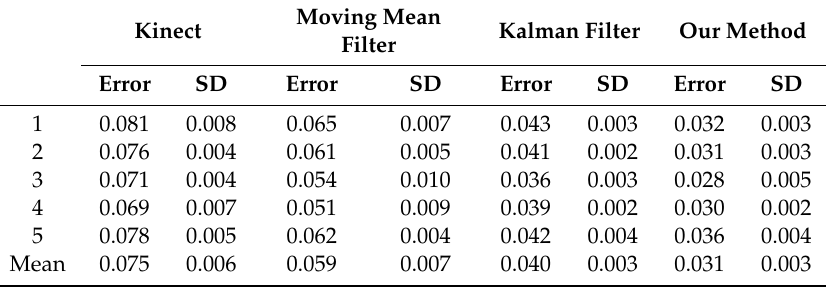
Table 2. Comparison of the error of di ff erent algorithms (unit: